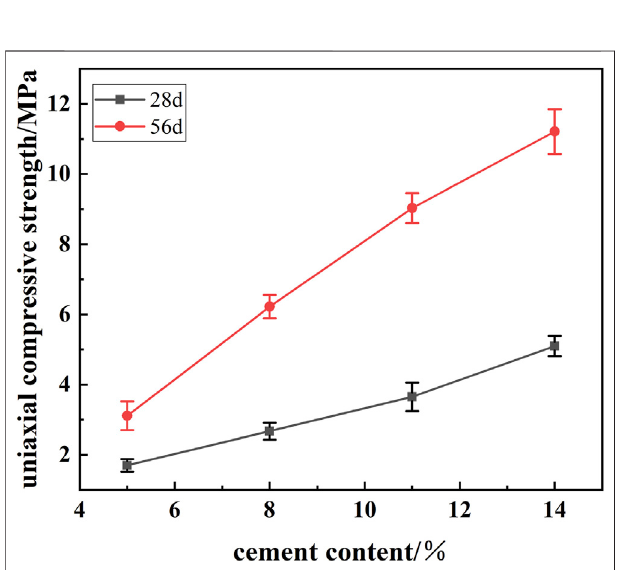
FIGURE 11 | The relationship between the strength of back fi ll and cement content (group